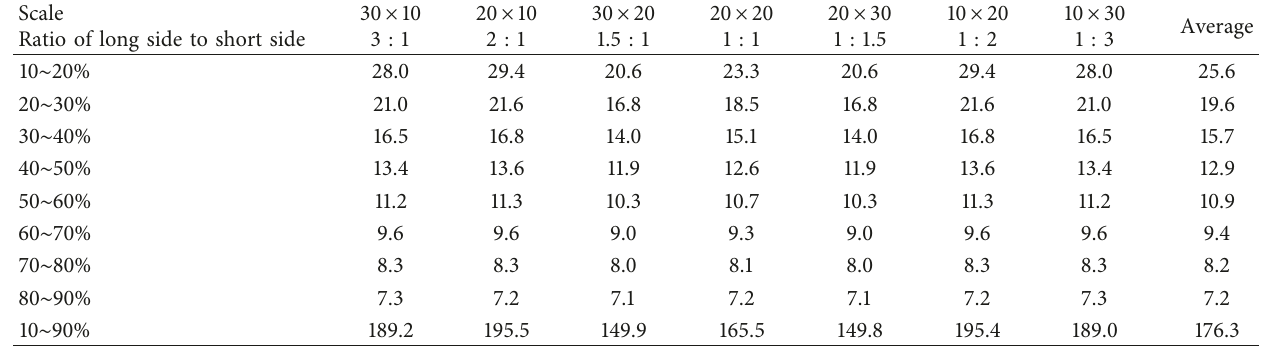
Table 5: Changes in energy expenditure per unit area due to ratio of long side to short side and window area ratio (%).